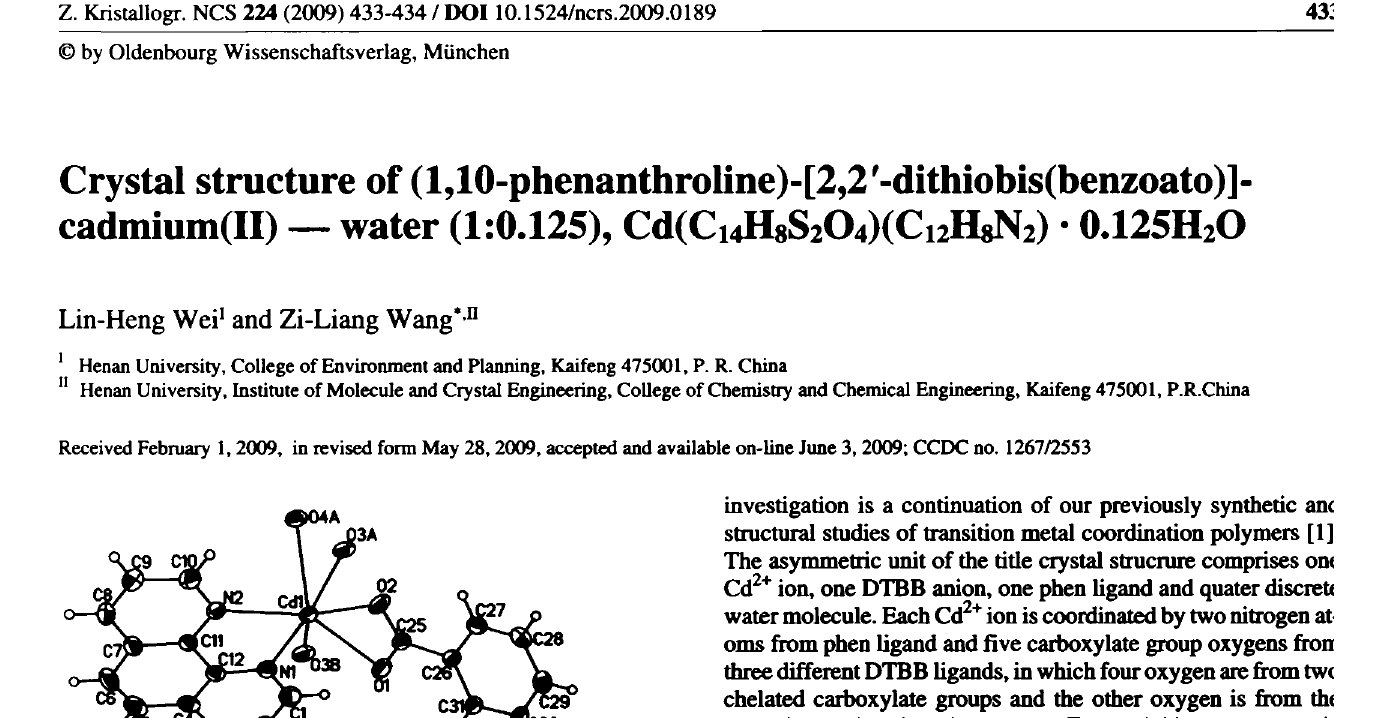
Table 1. Data collection and handling.